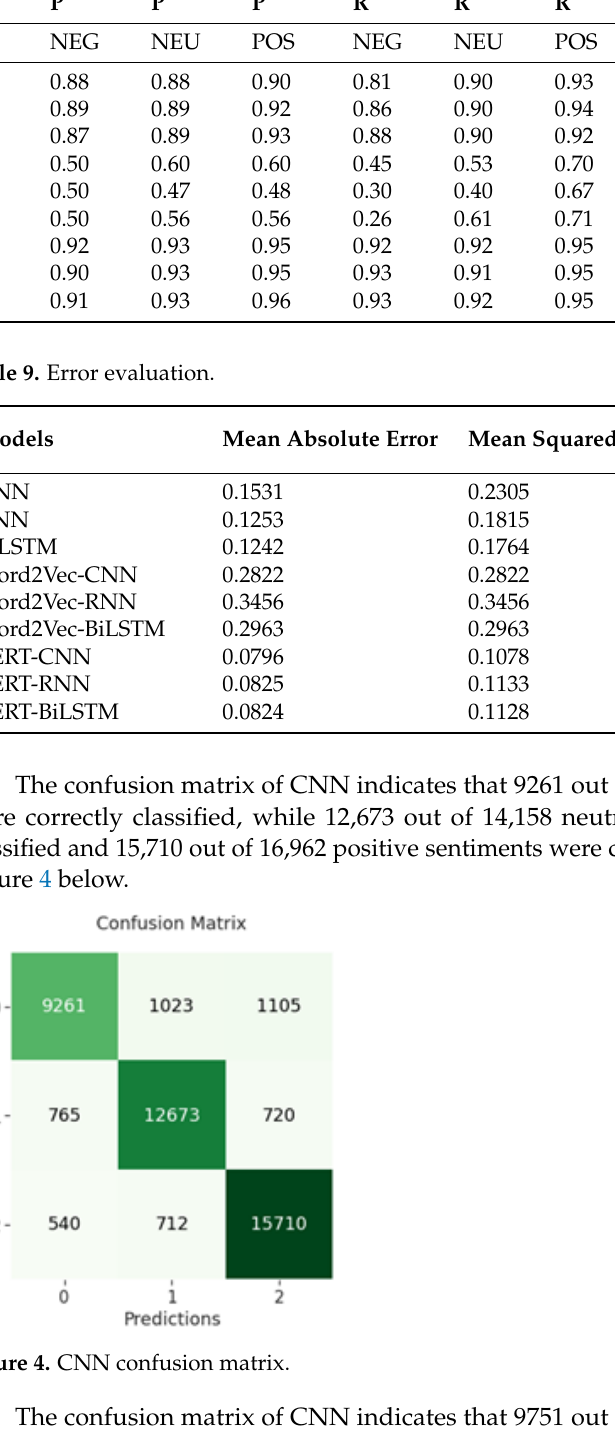
Figure 5. RNN confusion matrix. The confusion matrix of BiLSTM indicates that 9847 out of 11,221 negative sentiments were correctly classified, while 12,816 out of 14,272 neutral sentiments were correctly clas- sified and 15,700 out of 17,040 positive sentiments were correctly classified as shown in Figure 6 below.